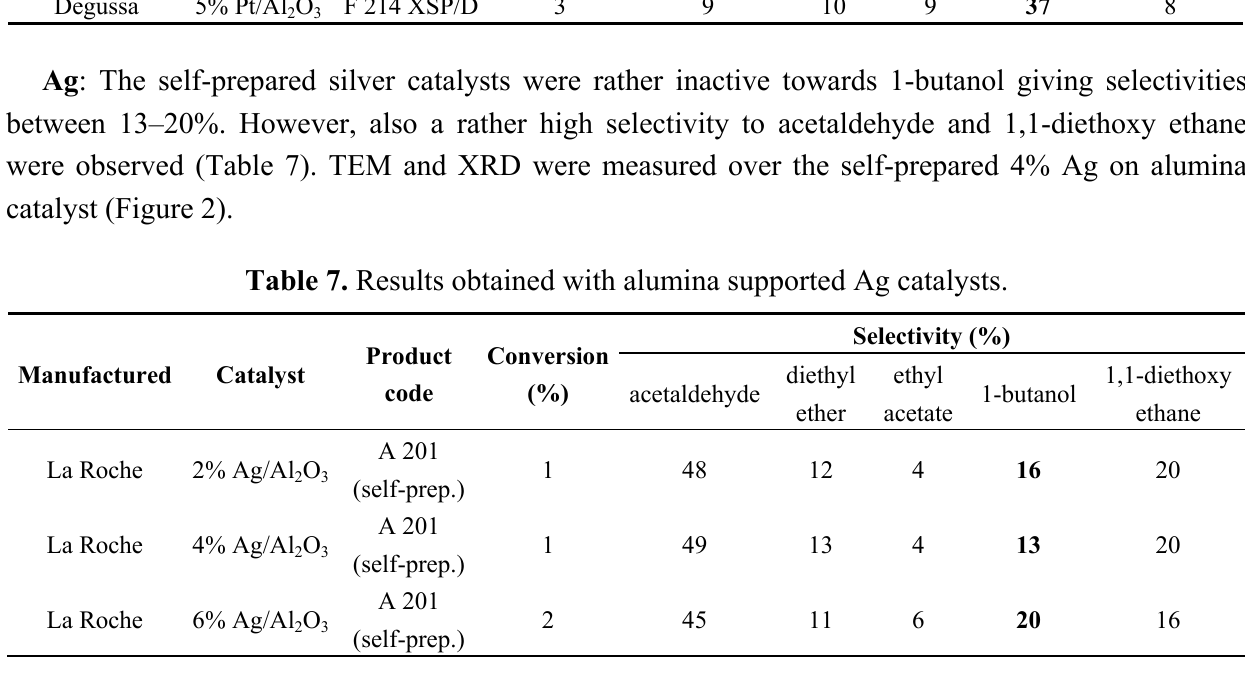
Figure 2. TEM and XRD pictures of self-prepared 4 wt% Ag/Al